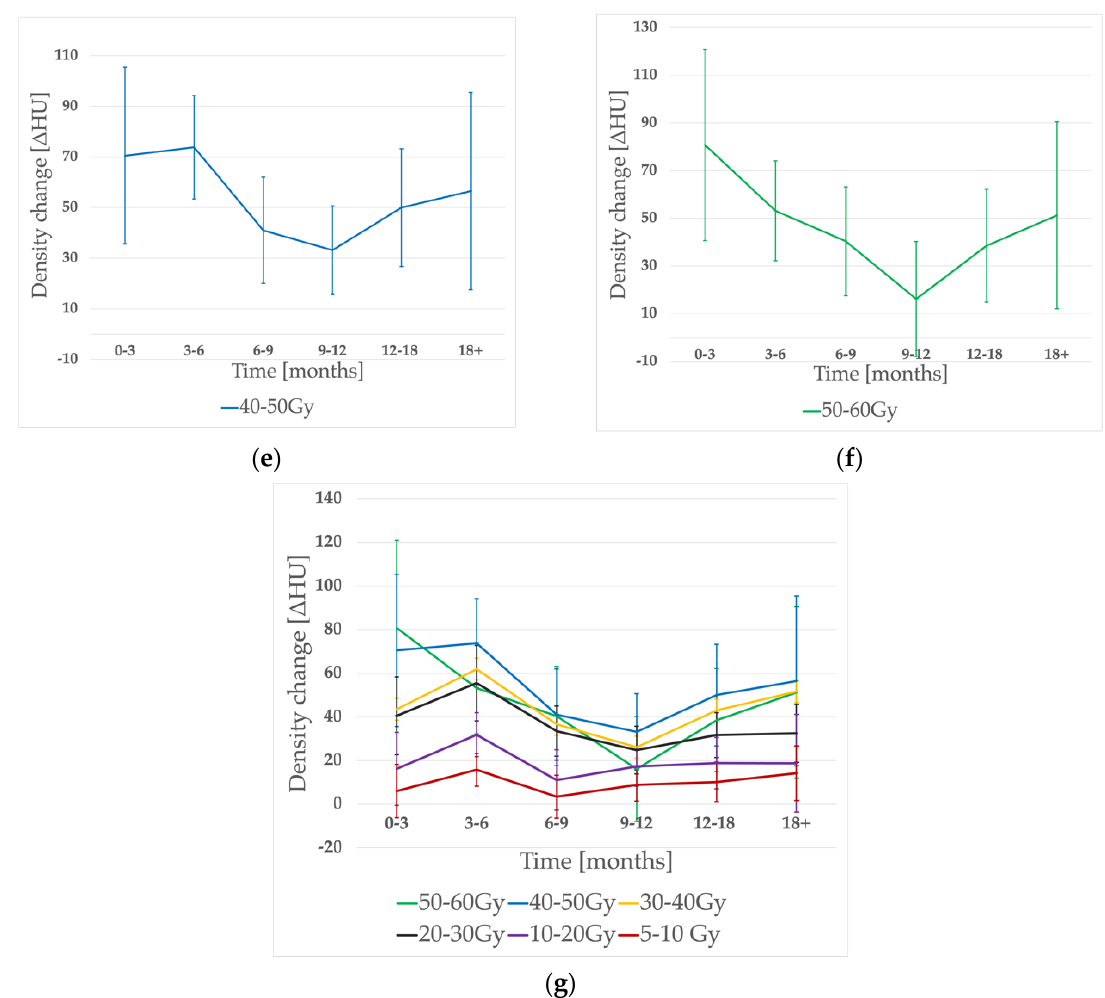
Figure 2. Density change evolution in time for different dose-bins: ( a ) 5 – 10 Gy, ( b ) 10 – 20 Gy, ( c ) 20 – 30 Gy, ( d ) 30 – 40 Gy, ( e ) 40 – 50 Gy, ( f ) 50 – 60 Gy, and ( g ) accumulated graph.